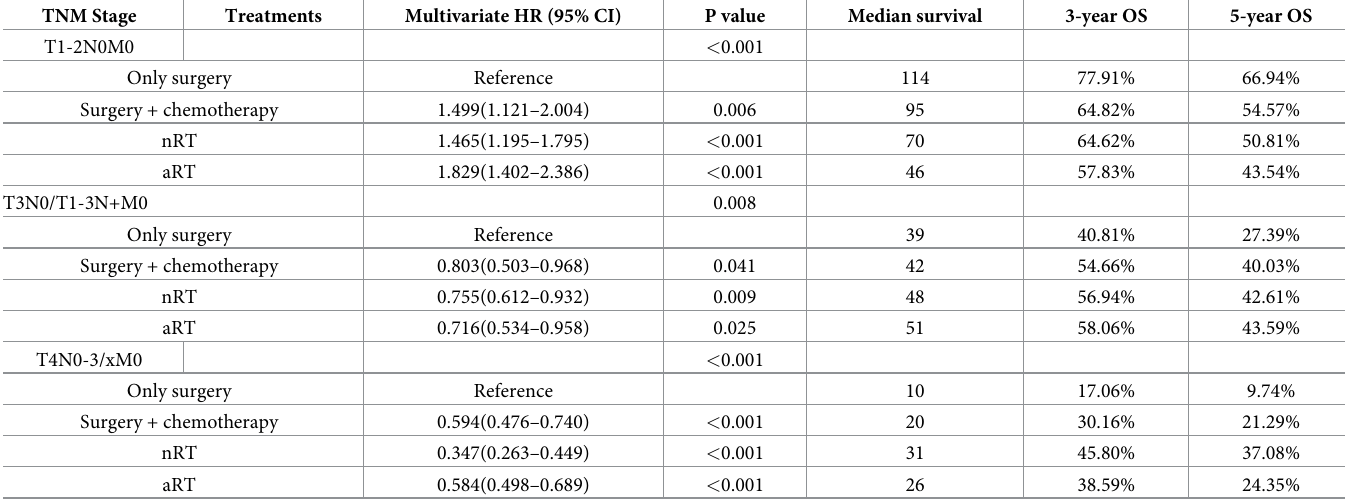
Table 3. Multivariate Cox analysis of OS with various treatment methods, median survival and 3-year and 5-year